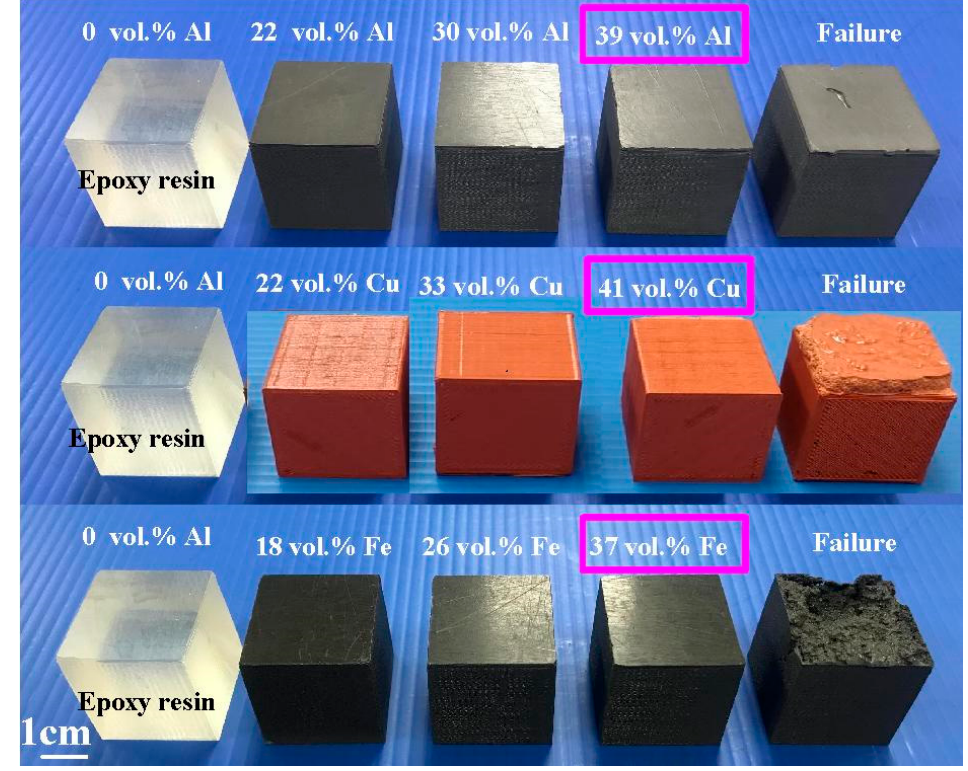
Figure 15. Experimental results of the upper limit of fillers.